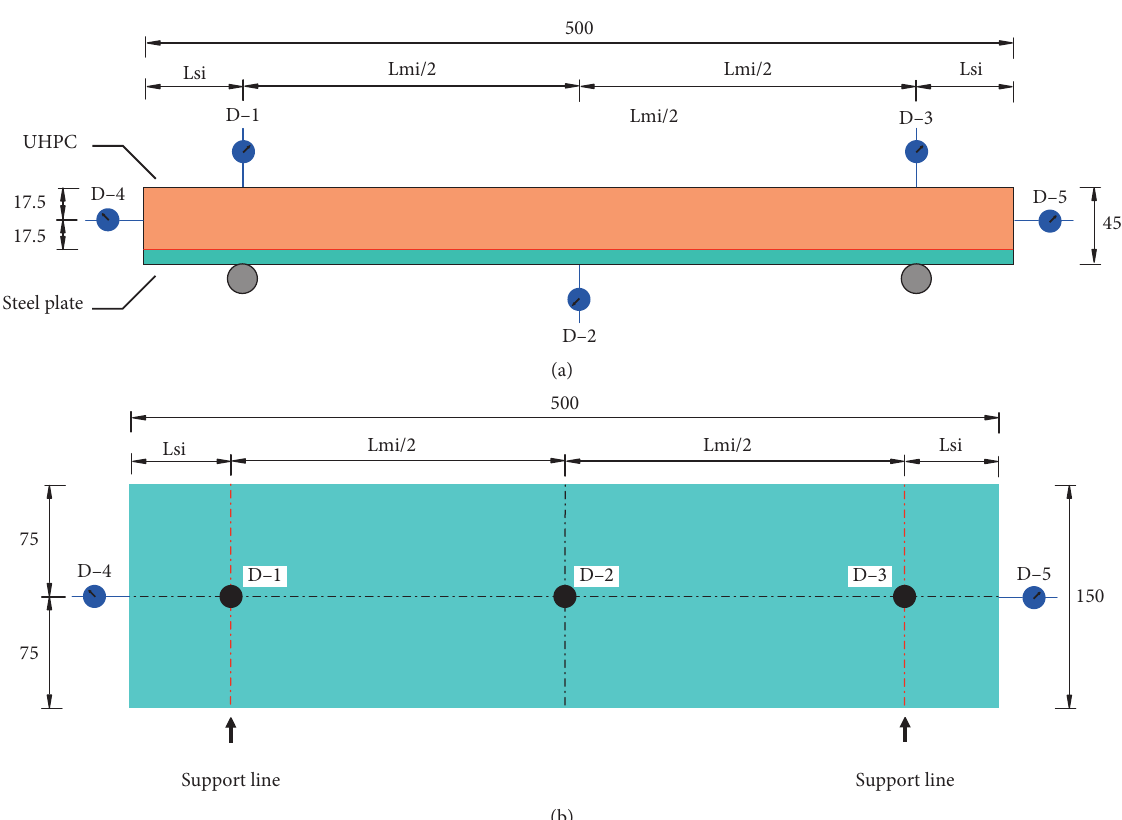
Figure 4: Arrangement of displacement measuring points. (a) front view and (b) plan view of displacement measuring point arrangement for the positive bending moment loading test (unit: mm).